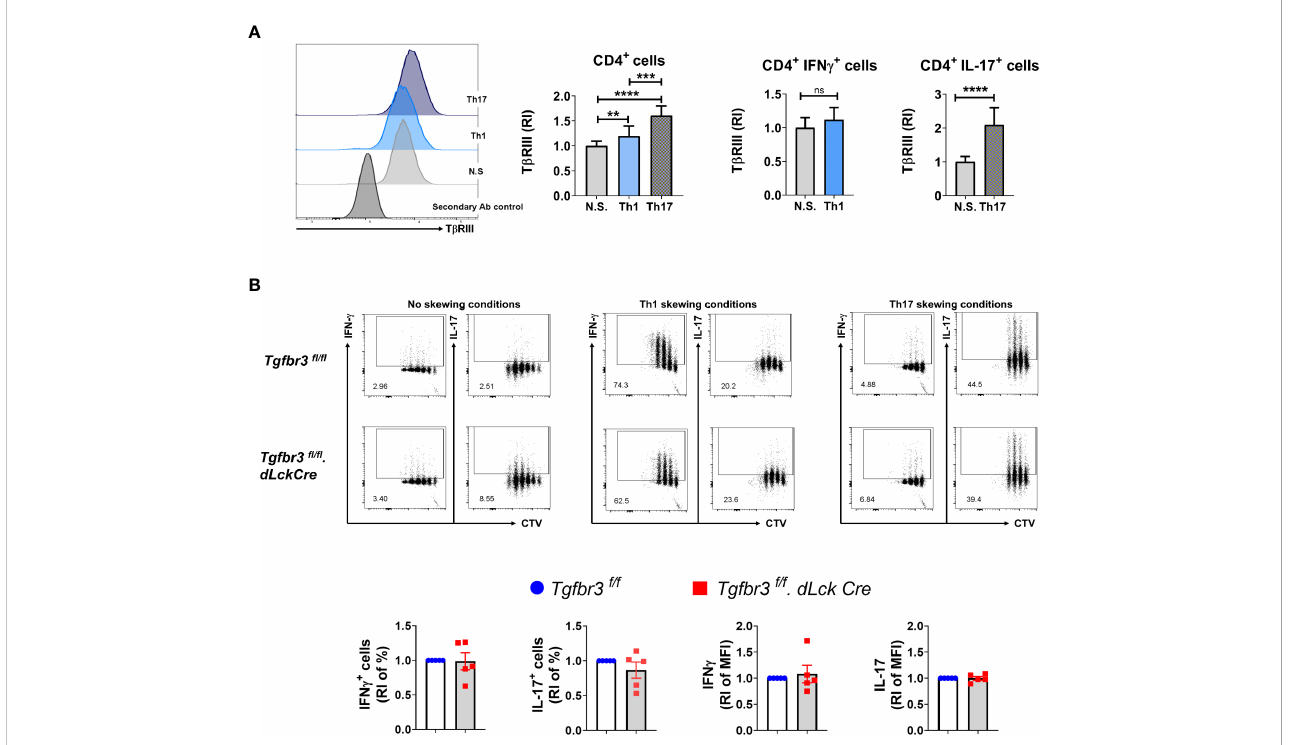
FIGURE 5 T b RIII on Th1 and Th17 cells in vitro differentiated CD4 + T cells. The expression of T b RIII was evaluated on CD4 + T cells under Th1, Th17 and non skewing (N.S) conditions. (A) T b RIII expression on CD4 + T cells under non skewing, Th1 and Th17 conditions. Representative histograms T b RIII expression on Th1, Th17, NS and secondary Ab control (left). Graphs of the increased T b RIII expression relative to non skewing conditions on CD4 + , CD4 + IFN g + and CD4 + IL17 + T cells (right). (B ) Representative dot plots of IFN- g + CTV + and IL-17 + CTV + live CD4 + T cells following in vitro Th1 and Th17 differentiation from Tgfbr3 fl / fl .dLcKCre (red) and Tgfbr3 fl / fl (blue) mice; below are the graphs of IFN- g or IL-17 increased percentage and median fl uorescence relative to non skewing compared to Th1 and Th17 skewing conditions. Bar graphs show mean ± SEM. *p ≤ 0.05, **p ≤ 0.01, ***p ≤ 0.001. n =5 independent experiments for all conditions